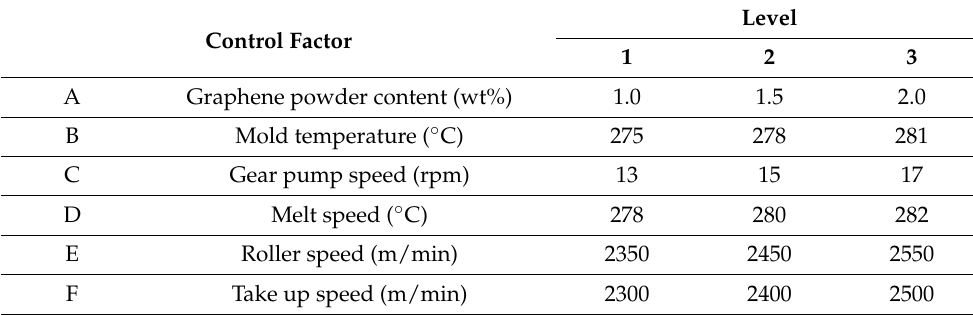
Table 1. Optimal parameter design of graphene-modified polyester fiber.